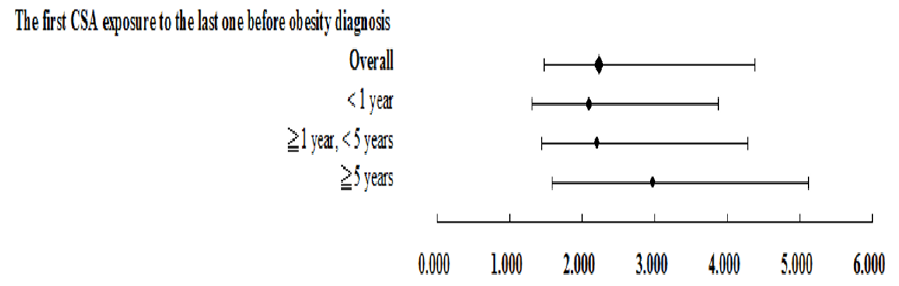
Figure 3. The first CSA exposure to the last one before obesity diagnosis.